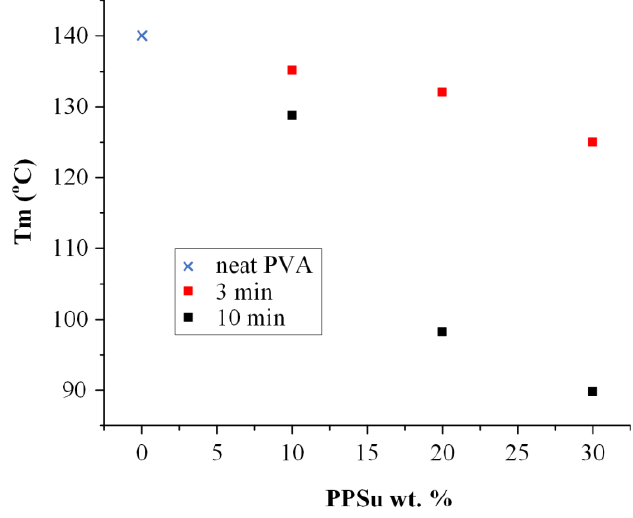
Figure 3. PVA’s Tm vs. PPSu % weight content for the neat PVA/PPSu matrices prepared after 3 or 10 min of melt mixing.